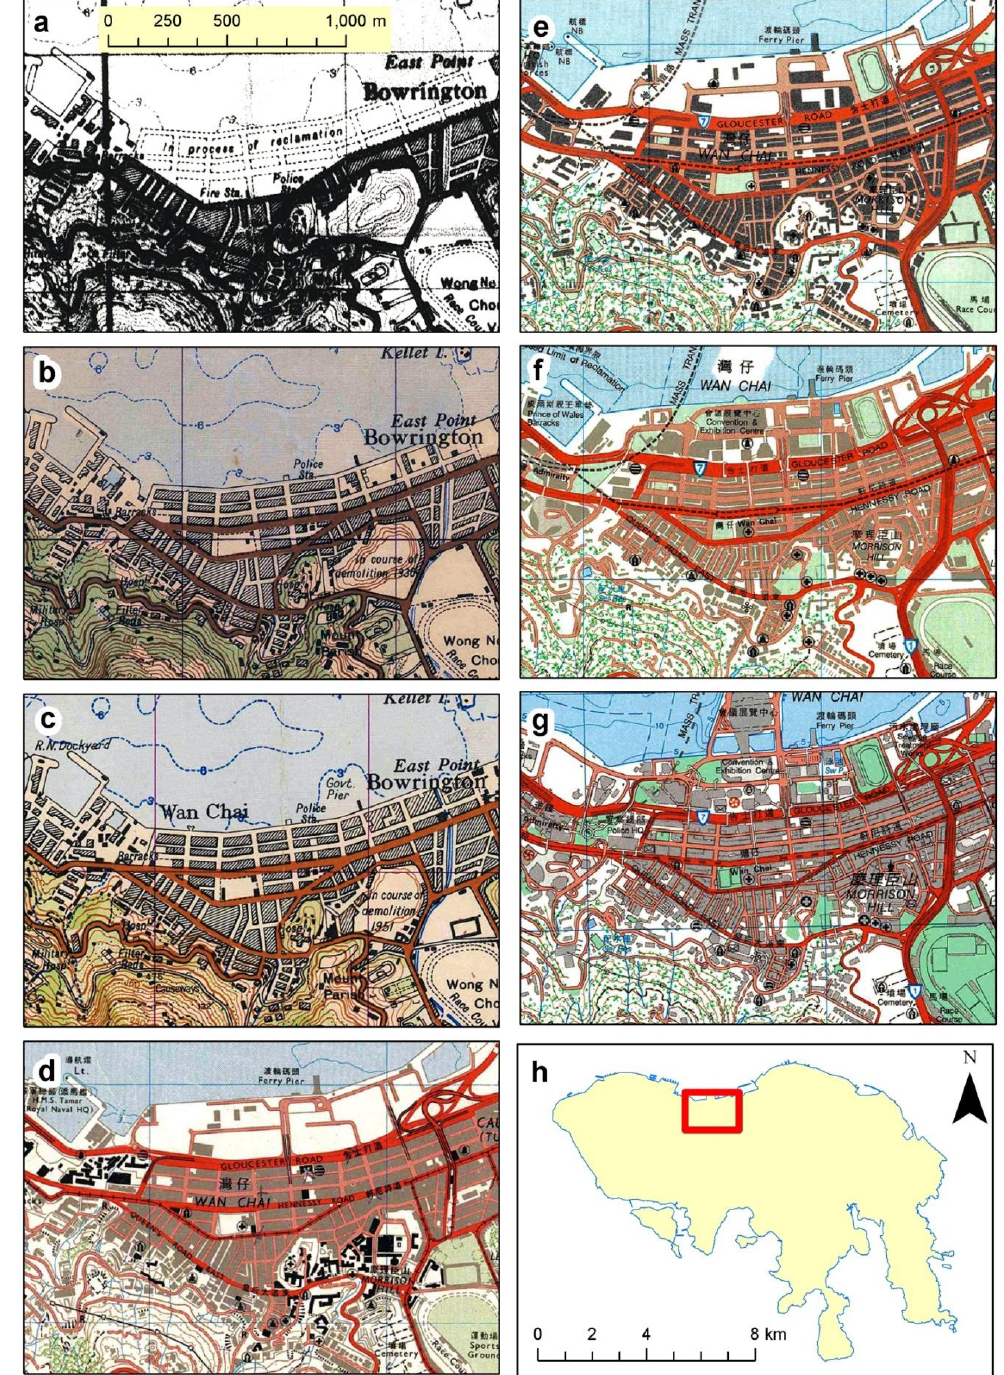
Figure 2. The historical 1:20,000 maps used for reconstructing the development stages of the Island of Hong Kong (showing the area of Wan Chai, in the north of Hong Kong Island): 1930 ( a ), 1945 ( b ), 1952 ( c ), 1975 ( d ), 1984 ( e ), 1993/5 ( f ), 2003/6 ( g ), location map ( h ). The maps reproduced with permission of the Director of Lands. © The Government of Hong Kong SAR. Licence No.